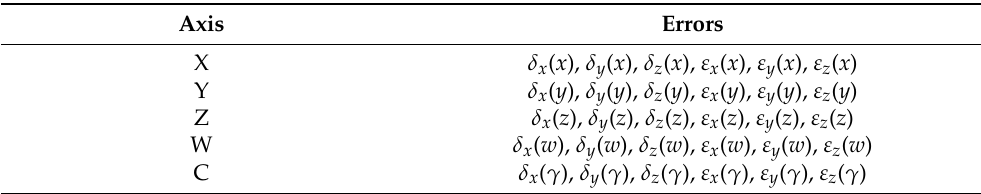
Table 1. Errors of each motion axis. Axis